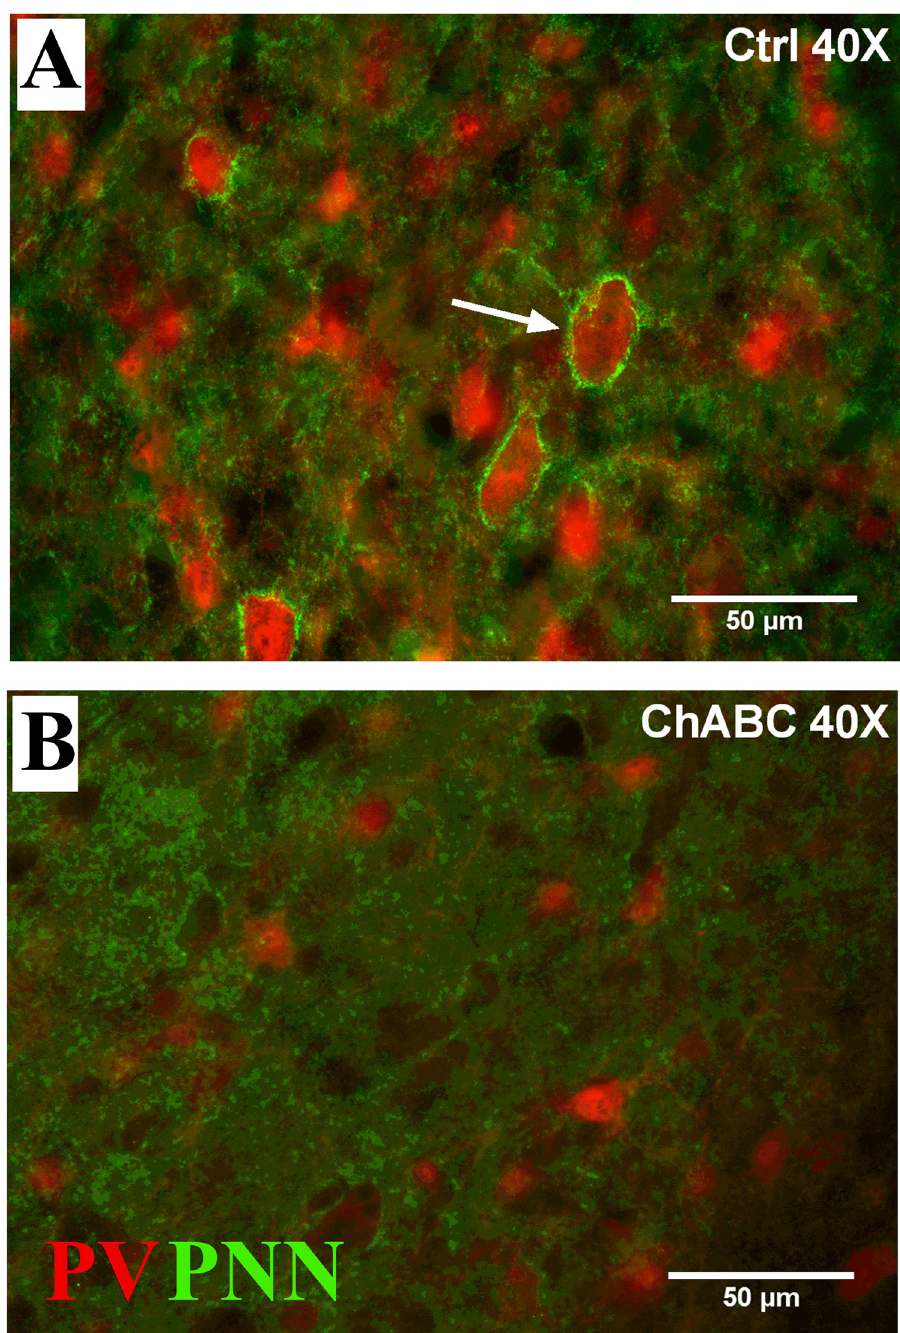
Fig 5. Photomicrographs of PNN and PV staining in HVC. The figure illustrates sections of a Ctrl (A) and a ChABC (B) treated male canary. PNN (green) are clearly visible around PV-positive cells (red) in the Ctrl (arrow) but not in the ChABC